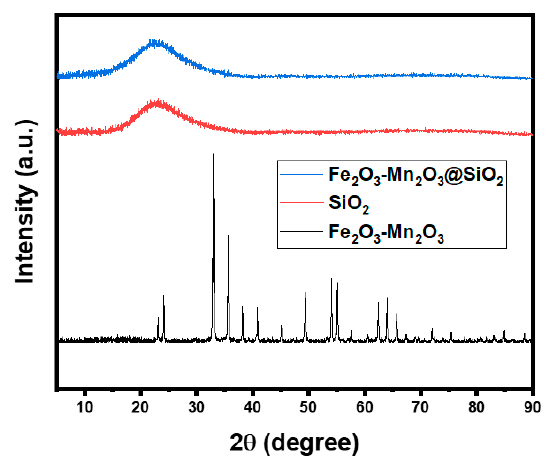
Figure 3. X-ray diffraction (XRD) patterns of synthesized photocatalyst; Fe 2 O 3 /Mn 2 O 3 nanoparticles (FM-NPs), Fe 2 O 3 /Mn 2 O 3 @SiO 2 (FMS), and bare SiO 2 .